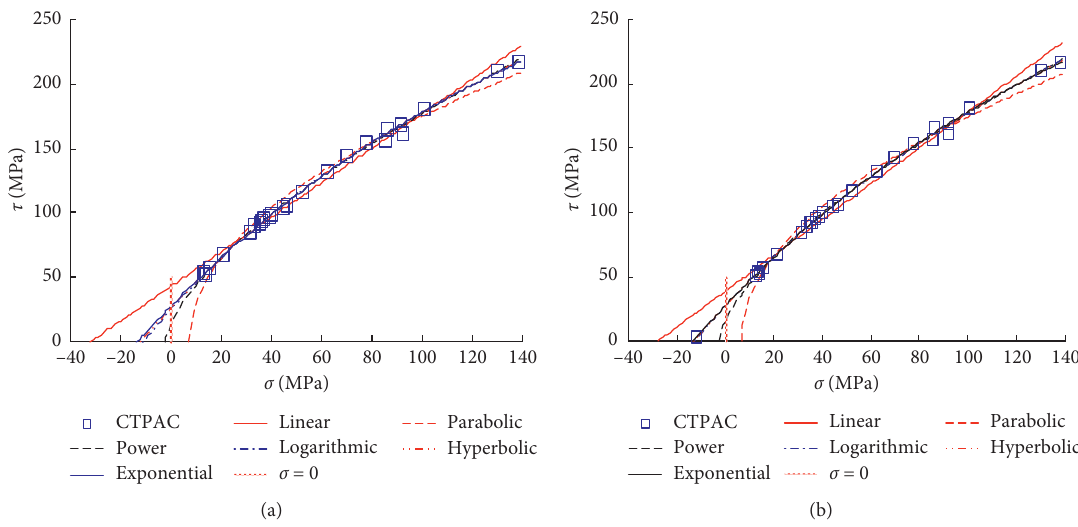
Figure 5: Typical strength envelope regression curves of specimen LG in the Mohr stress space. (a) ( σ (b) ( σ t ) t is included in regression.